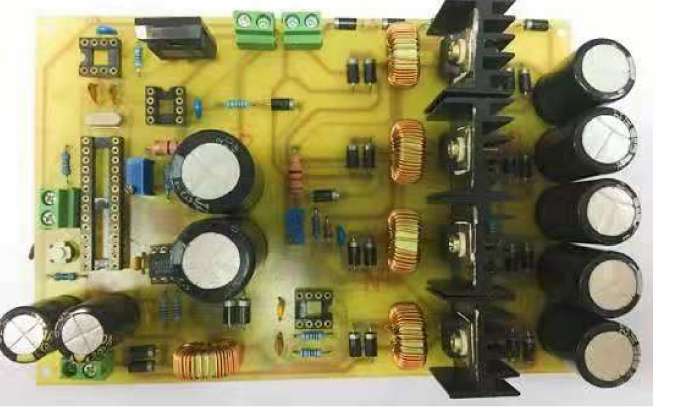
Figure 5. New three-pulse MOSFET injector driving circuit with A DC-Boost